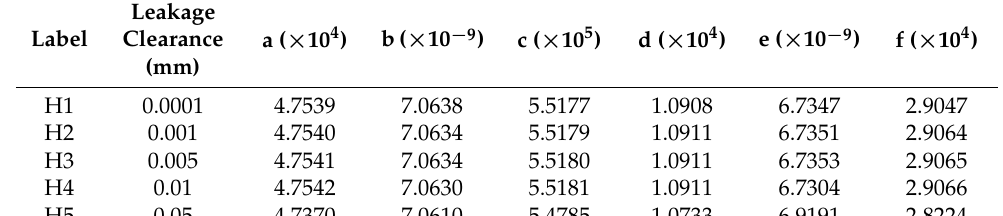
Table 7. Characteristic value of wavelet packet of reversing valve leakage.